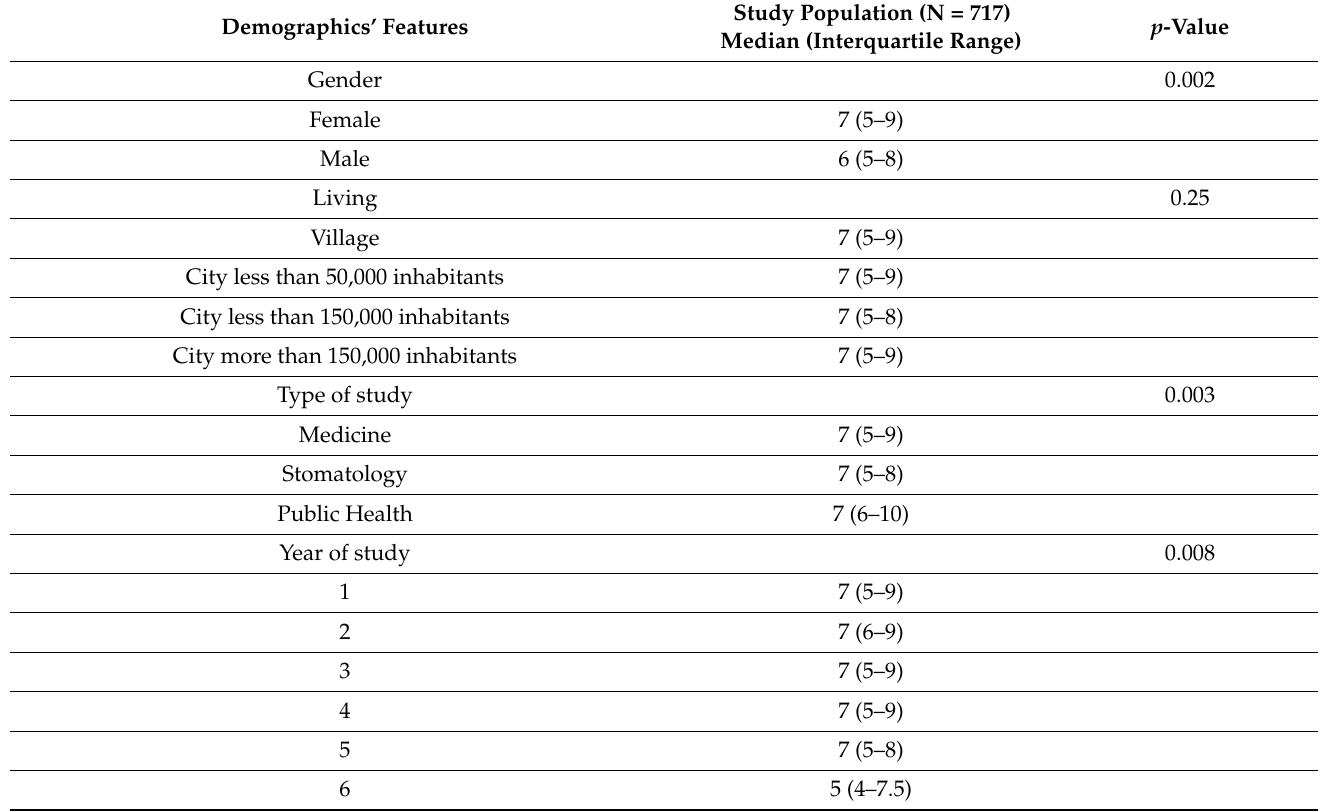
Table 3. Factors associated with fear of medical